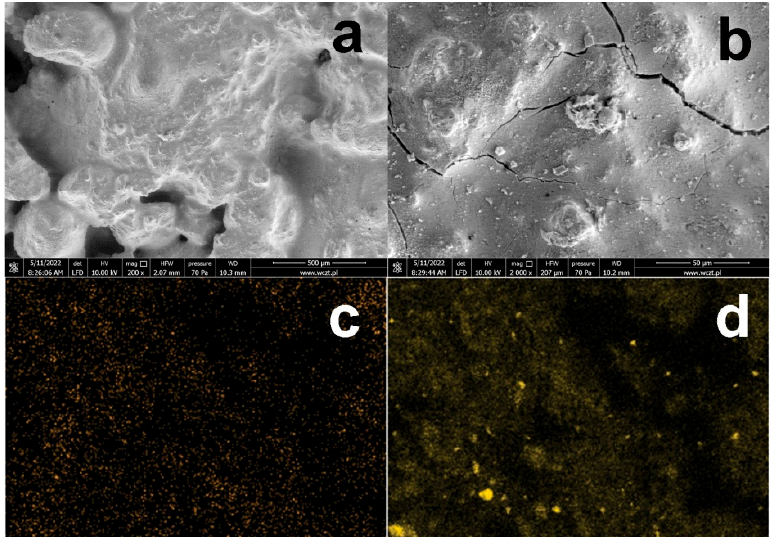
Figure 8. SEM images of concrete with a modified surface by neutral 5% OFTES solutions ( a , b ); EDS mapping of the elements on the F5* surface; element map of F ( c ) and Si ( d ).